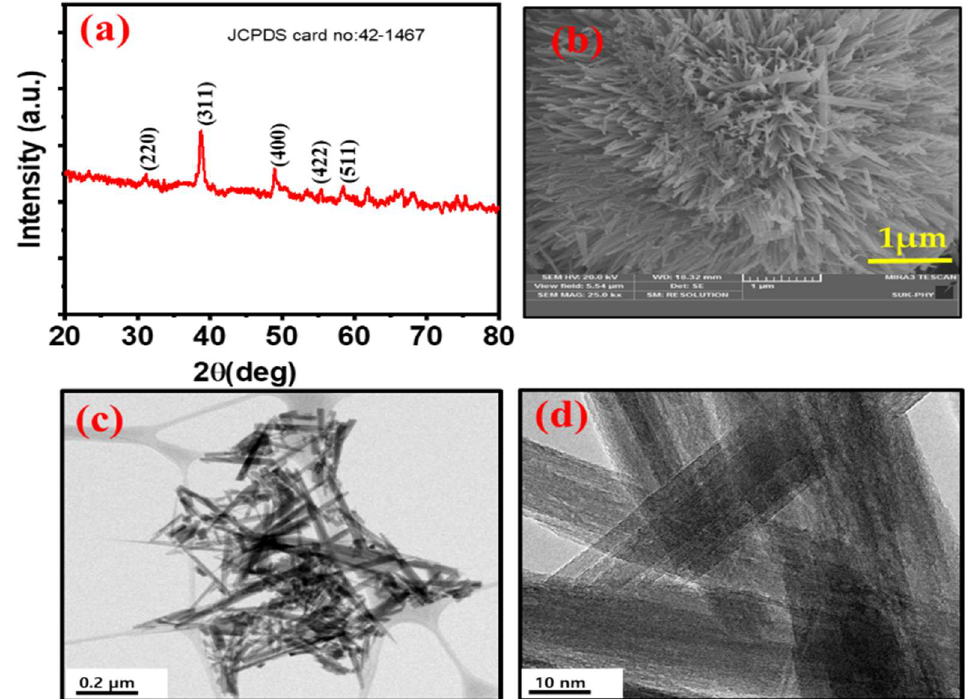
Figure 5. ( a ) XRD pattern, ( b ) SEM images, and ( c , d ) TEM images for the Co 3 O 4 thin film.